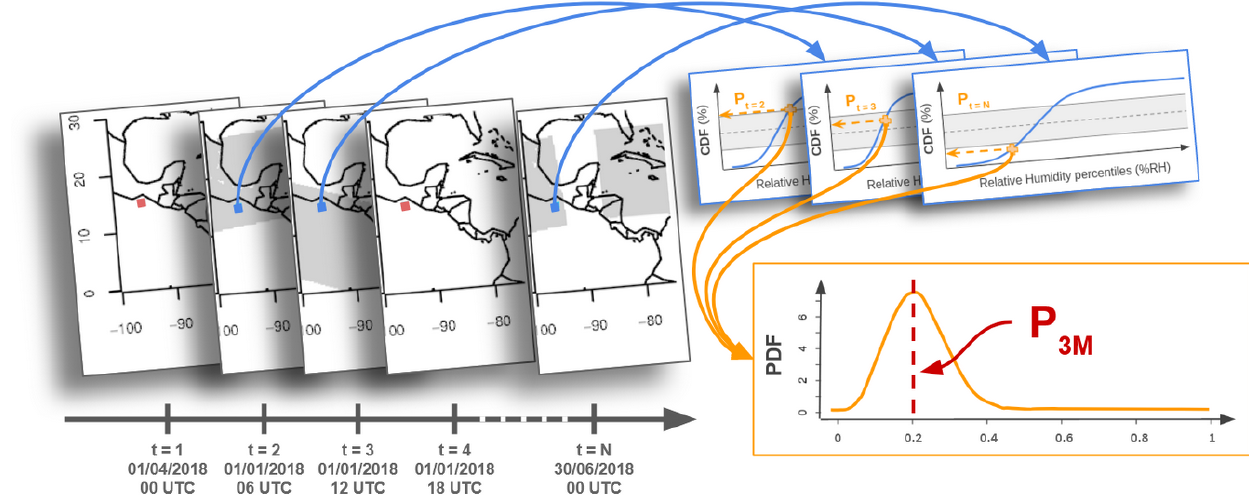
Figure 3. Diagram presenting the spatial and temporal aggregation method for a single grid point (blue square when the grid box was passed over by SAPHIR, red when not and/or filtered out). P 3M is the mode of the distribution aggregated over all the considered time steps for this grid